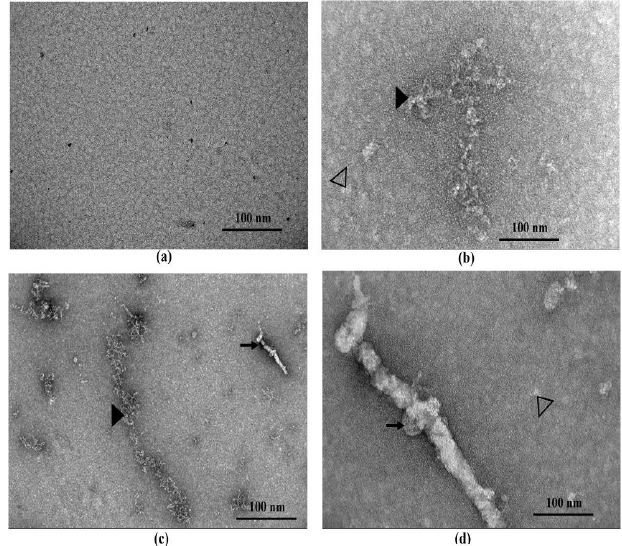
Figure 4. The TEM micrograph of huTTR incubated in the presence or absence of CAB. ( a ) Human transthyretin (TTR) in GF buffer, pH 7.4 supplemented with GMSO and incubated at − 20 °C. ( b ) Human TTR supplemented CAB, final pH 4.0 and incubated at 37 °C for 7 days. ( c ) Human TTR supplemented with GMSO, pH 4.0 and incubated at 37 °C for 7 days. ( d ) Same image as ( c ) but with higher magnification. Arrows represent mature fibrils, filled arrow-heads large amorphous aggregates, and not-filled arrow-heads oligomers.